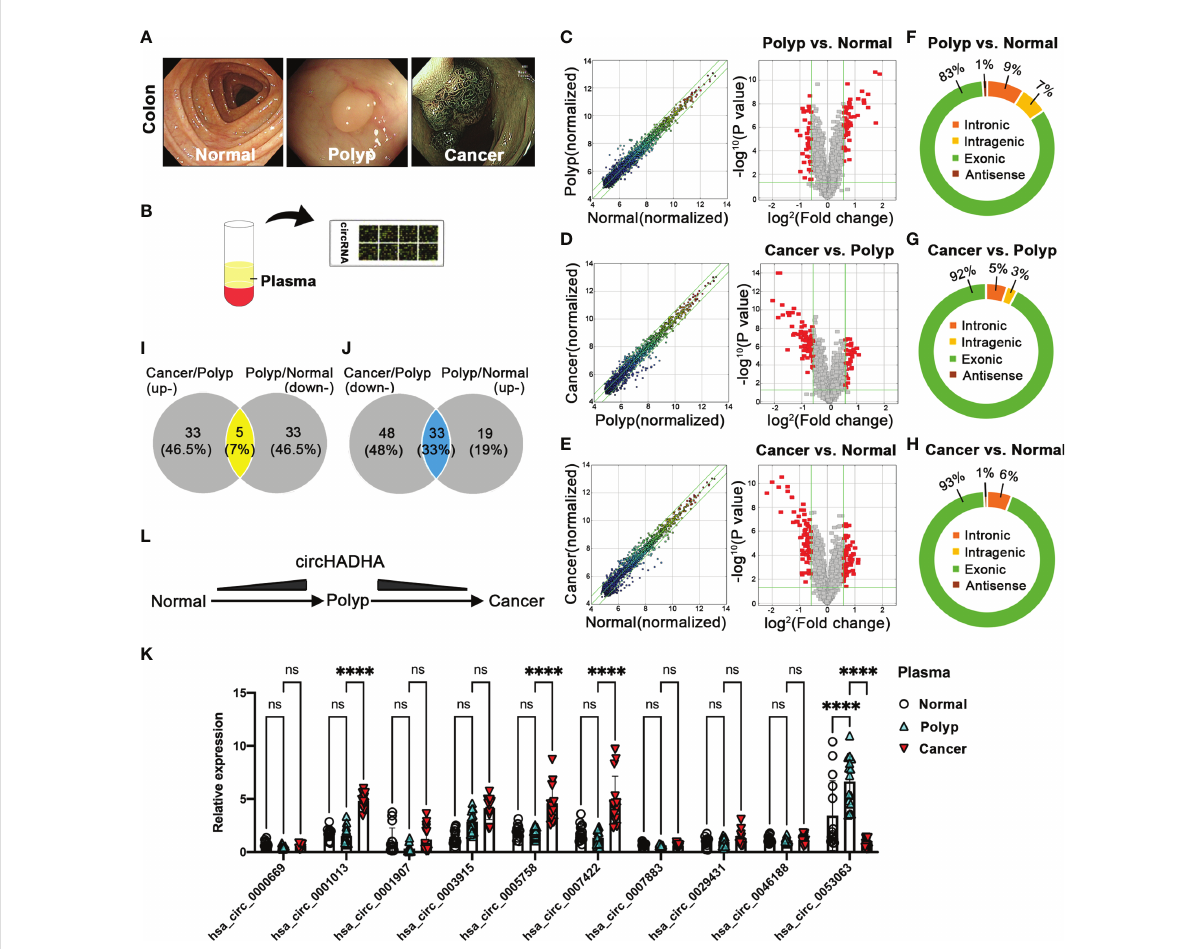
FIGURE 1 Plasma circRNA expression pattern in healthy individuals and colon polyp and colon cancer patients. (A) The endoscopic diagnosis of healthy individuals (left panel) and colon polyp (central panel) and colon cancer (right panel) patients. (B) The schematic diagram of Arraystar assay performance in plasma circRNAs. (C) The differential expression of plasma circRNAs in polyp patients ( N = 5) and healthy individuals ( N = 5). The expression variation of circRNAs was assessed by the scatter plot between polyp patients and healthy individuals (left panel). The green lines represented fold change lines. The circRNAs above the top green line and below the bottom green line indicated more than 1.5-fold change of circRNAs between the two compared samples. The differential expression of circRNAs was analyzed by volcano plots between polyp patients and healthy individuals (right panel). Red points represented the differentially expressed circRNAs with statistical signi fi cance (1.5-fold upregulation and downregulation, P < 0.05). (D) The differential expression of plasma circRNAs in colon cancer ( N = 5) and colon polyp patients ( N = 5). The expression variation of circRNAs was assessed by the scatter plot between colon cancer and colon polyp patients (left panel). The green lines represented fold change lines. The circRNAs above the top green line and below the bottom green line indicated more than 1.5-fold change of circRNAs between the two compared samples. The differential expression of circRNAs was analyzed by volcano plots between colon cancer and colon polyp patients (right panel). Red points represented the differentially expressed circRNAs with statistical signi fi cance (1.5-fold upregulation and downregulation, P < 0.05). (E) The differential expression of plasma circRNAs in colon cancer patients ( N = 5) and healthy individuals ( N = 5). The expression variation of circRNAs was assessed by the scatter plot between colon cancer patients and healthy individuals (left panel). The green lines represented fold change lines. The circRNAs above the top green line and below the bottom green line indicated more than 1.5-fold change of circRNAs between the two compared samples. The differential expression of circRNAs was analyzed by volcano plots between cancer patients and healthy individuals (right panel). Red points represented the differentially expressed circRNAs with statistical signi fi cance (1.5-fold upregulation and downregulation, P < 0.05). (F – H) The composition of types in detectable circRNAs. (F) The composition of circRNA types in polyp and colon cancer patients. (I) The Venn analysis between upregulated circRNAs from colon cancer patients compared with colon polyp patients and downregulated circRNAs from colon polyp patients compared with healthy individuals. (J) The Venn analysis between downregulated circRNAs from colon cancer patients compared with colon polyp patients and upregulated circRNAs from colon polyp patients compared with healthy individuals. (K) The potential circRNA candidates were validated by performing real-time PCR in plasma from healthy individuals ( N = 15) and colon polyp ( N = 15) and colon cancer ( N = 15) patients. (L) The schematic diagram of circHADHA dynamic alteration in healthy individuals and colon polyp and colon cancer patients. **** P < 0.0001; ns, no signi fi cant